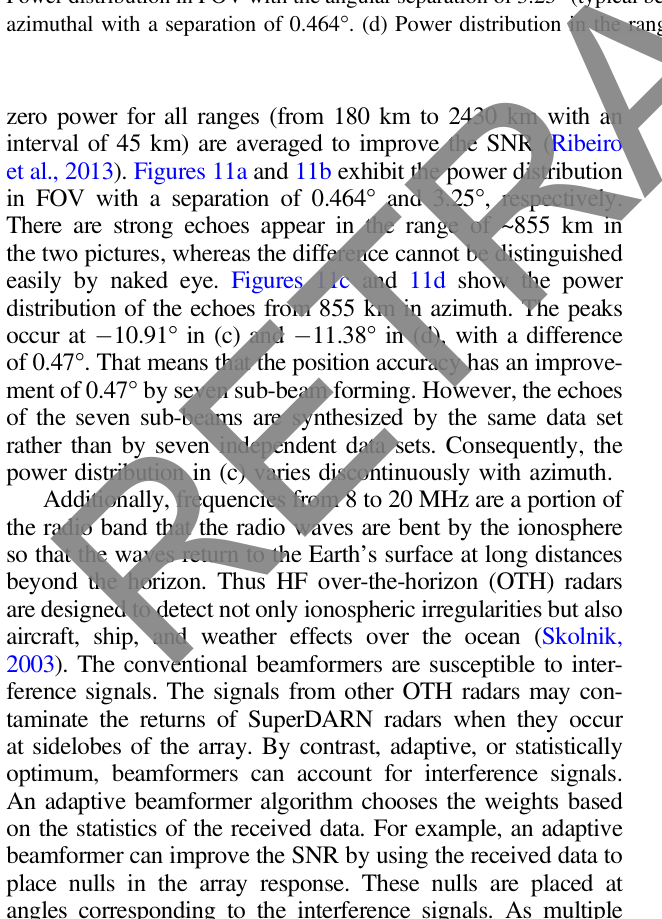
Figure 11. Power distribution in FOV. (a) Power distribution in FOV with the angular separation of 0.464 (cid:3) (seven sub-beam forming). (b) Power distribution in FOV with the angular separation of 3.25 (cid:3) (typical beam forming). (c) Power distribution in the range of 855 km varying in azimuthal with a separation of 0.464 (cid:3) . (d) Power distribution in the range of 855 km varying in azimuthal with a separation of 3.25 (cid:3)